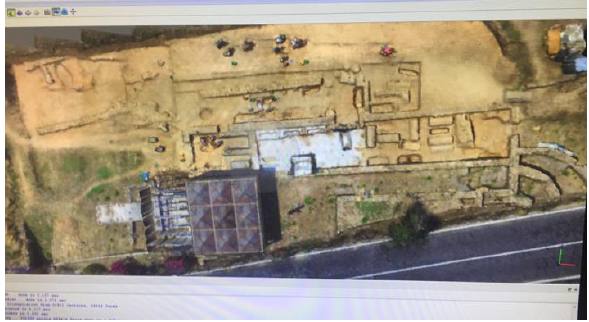
Figure 4. Mesh, the site of Capo Don ‘ Costa Balenae ’.